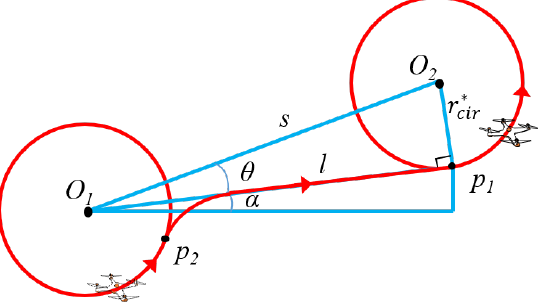
Figure 8. The calculation of the entry position of a Dubins arc.